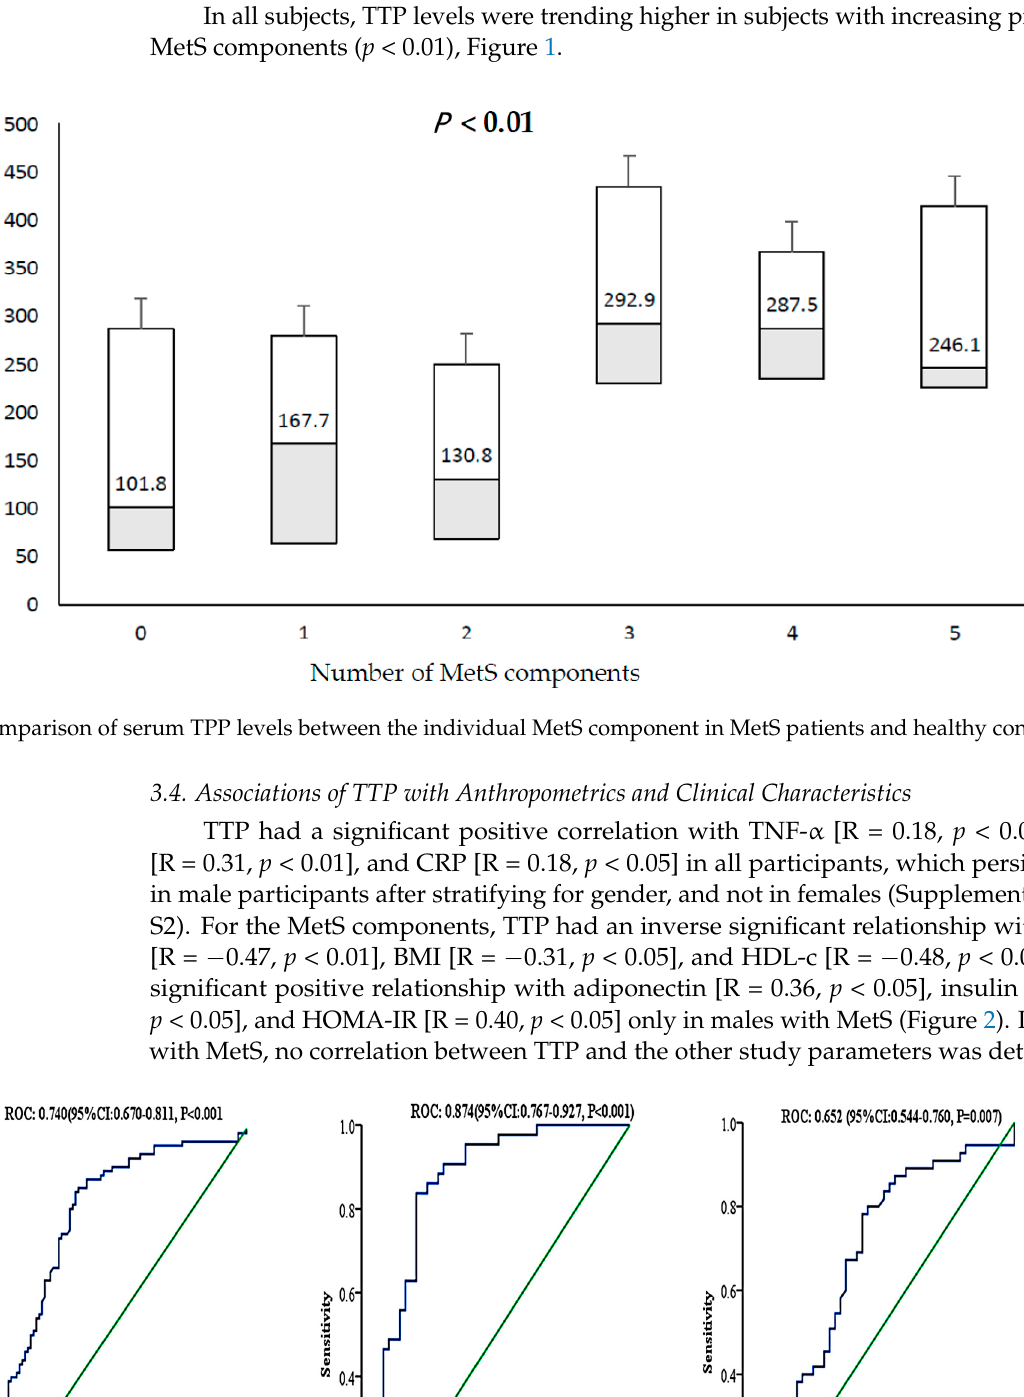
Table 3. Relationship between MetS components and TTP among males and females.